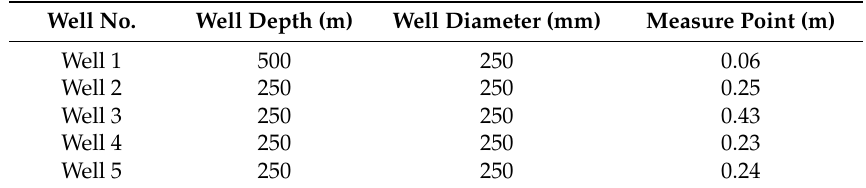
Figure 3. Experimental site plan. Table 1. Well specifications.